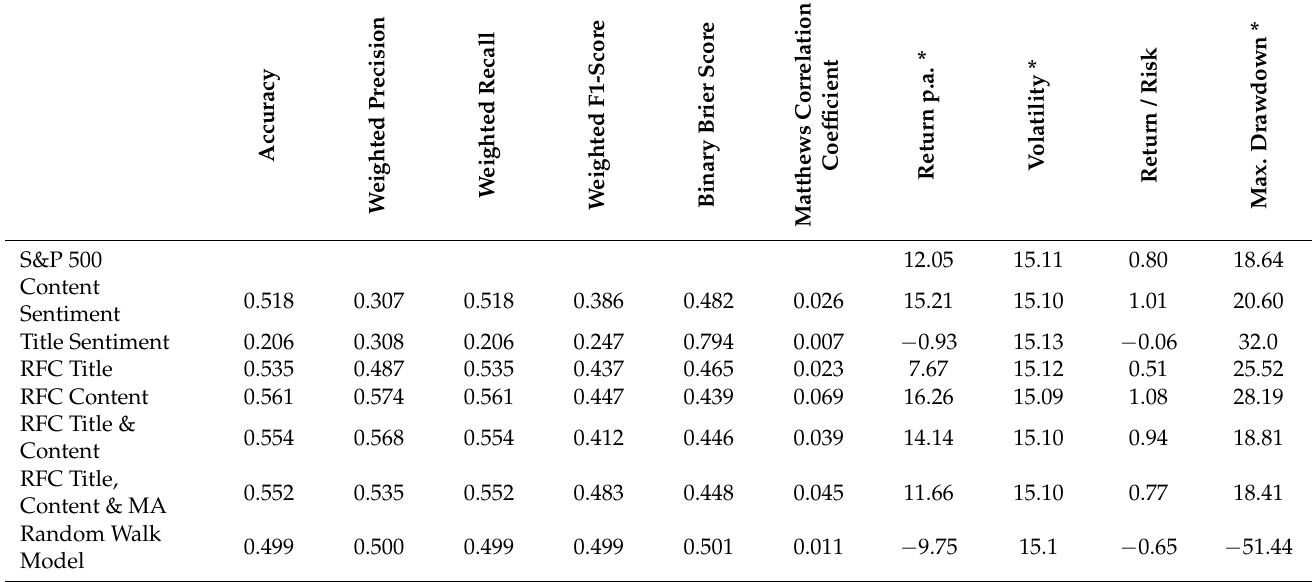
Table A1. Summary of empirical results, random forest classification optimized by the weighted precision